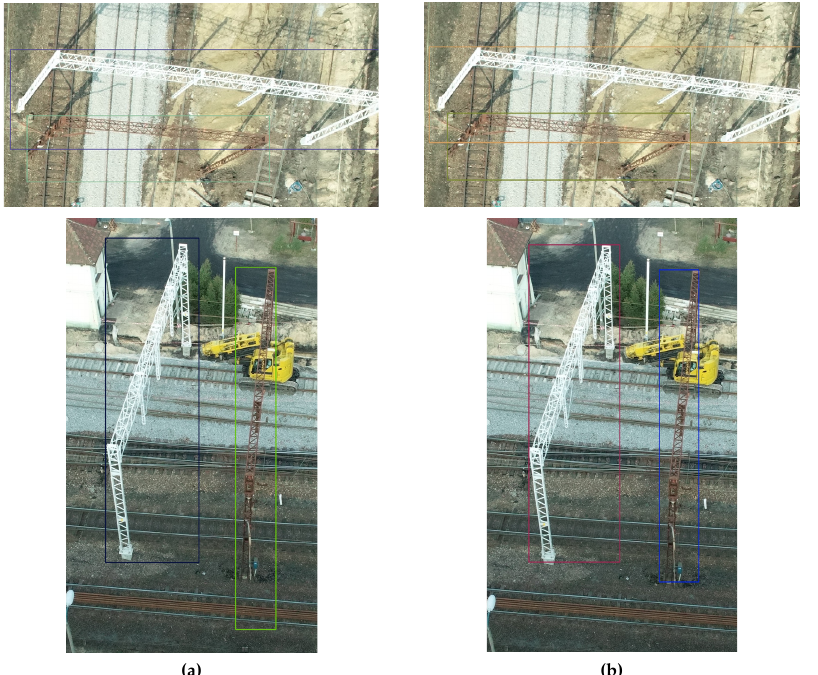
Figure 11. Example results for gates: ( a ) bounding boxes obtained from point cloud from DIM, ( b ) ground-truth bounding boxes obtained from point cloud from TLS.